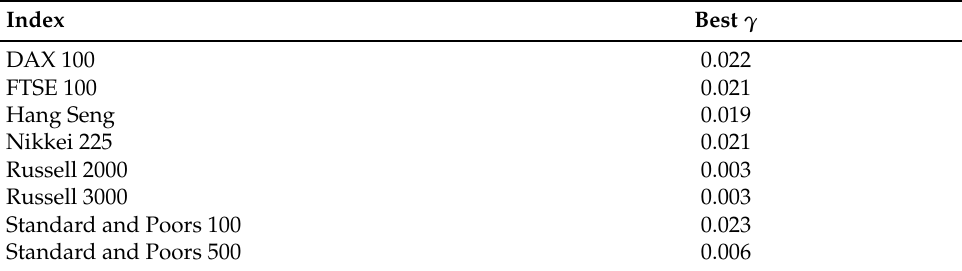
Table 6. Penalty Coefficients γ that Minimize the Objective